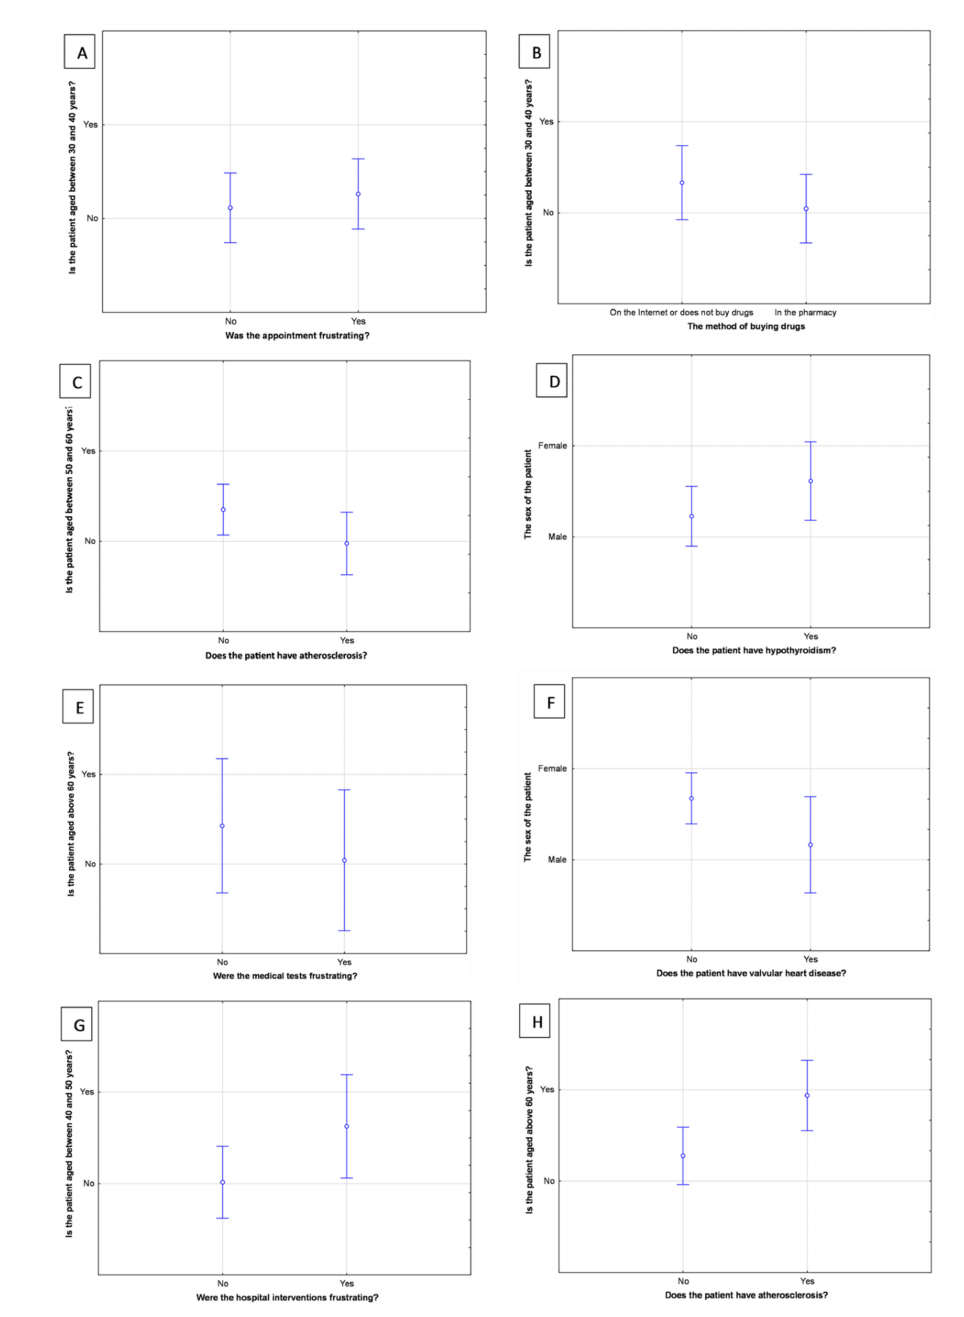
Figure 2. The results of general linear models. ( A ) The frustration of the appointment at the doctor in the group of patients aged between 30 and 40 years. ( B ) The method of buying the drugs in the group of patients aged between 30 and 40 years. ( C ) The occurrence of atherosclerosis in the group of patients aged between 50 and 60 years. ( D ) The occurrence of hypothyroidism in males and females. ( E ) The frustration of the medical tests in the group of patients aged above 60 years. ( F ) The occurrence of valvular heart disease in males and females. ( G ) The frustration of the hospital interventions in the group of patients aged between 40 and 50 years. ( H ) The occurrence of atherosclerosis in the group of patients aged above 60 years. Panels show box-and-whiskers plots. The panels present the statistical relationship between particular variables at the X and Y axes. The longer the whiskers are and the more centrally the median point is located between variables, the weaker correlation between the two variables presented at the X and Y